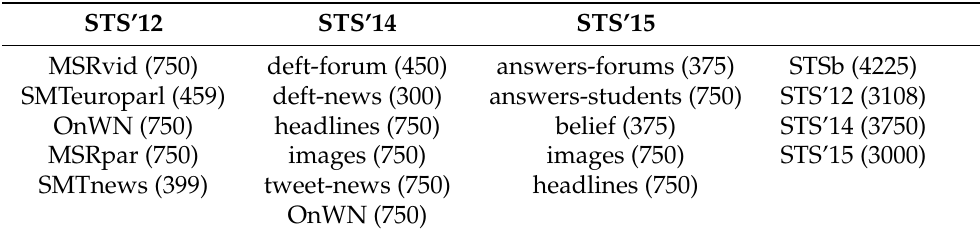
Table 2. The number of sentence pairs in each